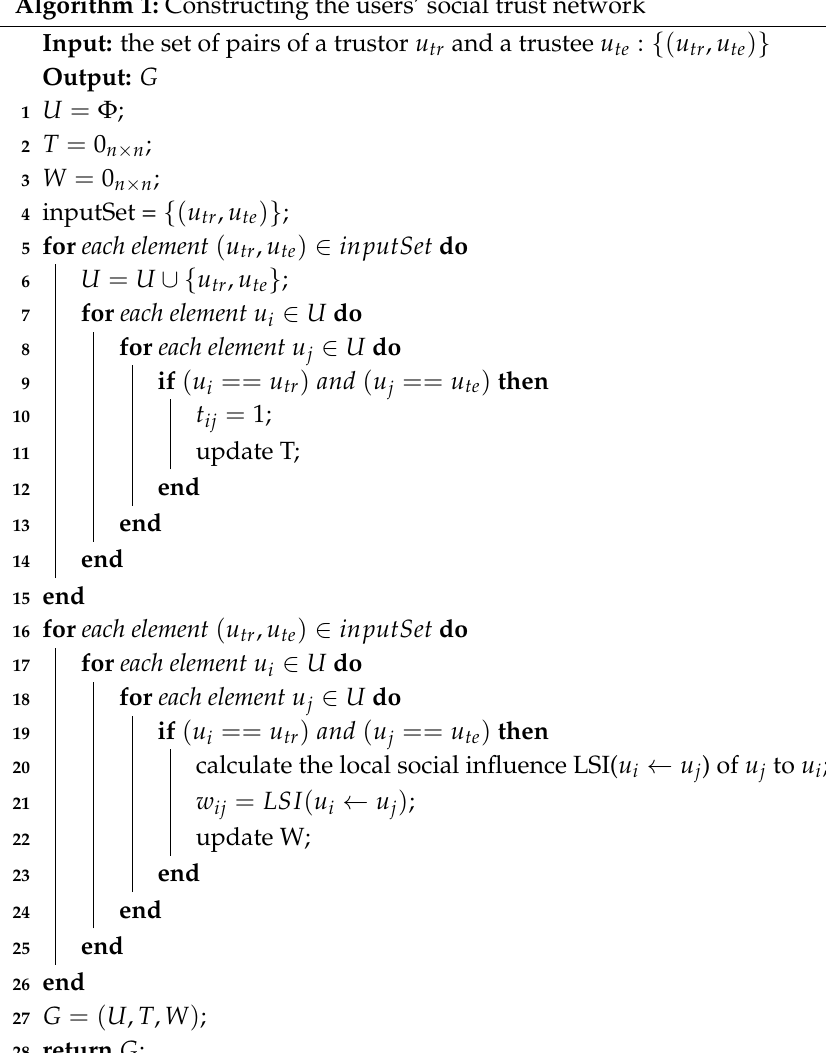
Algorithm 1: Constructing the users’ social trust